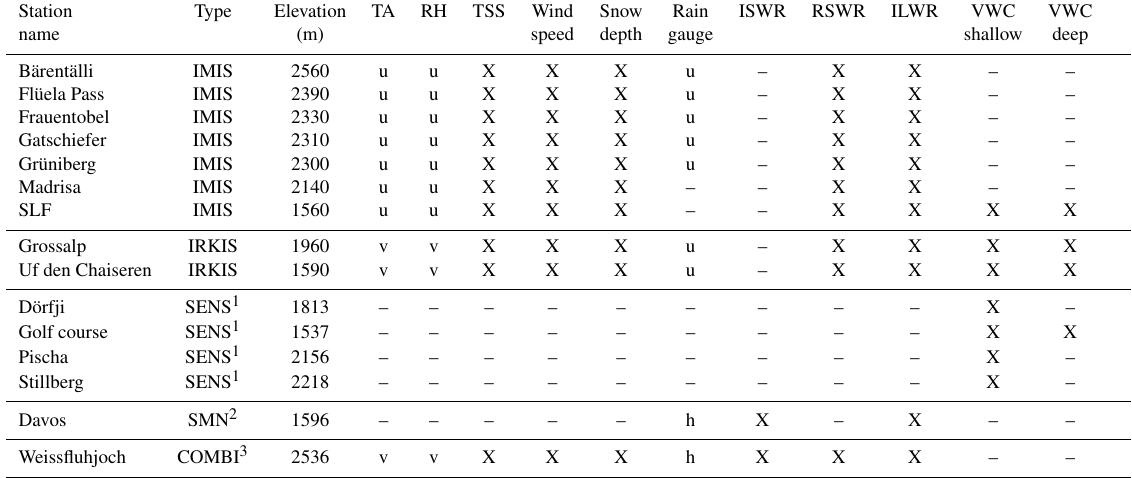
Table 2. List of stations and measured quantities at the stations that are used in this study. “X” indicates measured and used in this study; “–” indicates not measured; “u” indicates unventilated (temperature) or unheated (rain gauge); “v” indicates ventilated; “h” indicates heated rain gauge. Volumetric water content (VWC) shallow denotes soil moisture sensors at 10, 30 and 50cm depths; VWC deep denotes soil moisture sensors at 80 and 120cm depths. TA indicates air temperature, RH indicates relative humidity, TSS indicates surface temperatures, ISWR indicates incoming short-wave radiation, RSWR indicates reflected short-wave radiation and ILWR indicates incoming long-wave